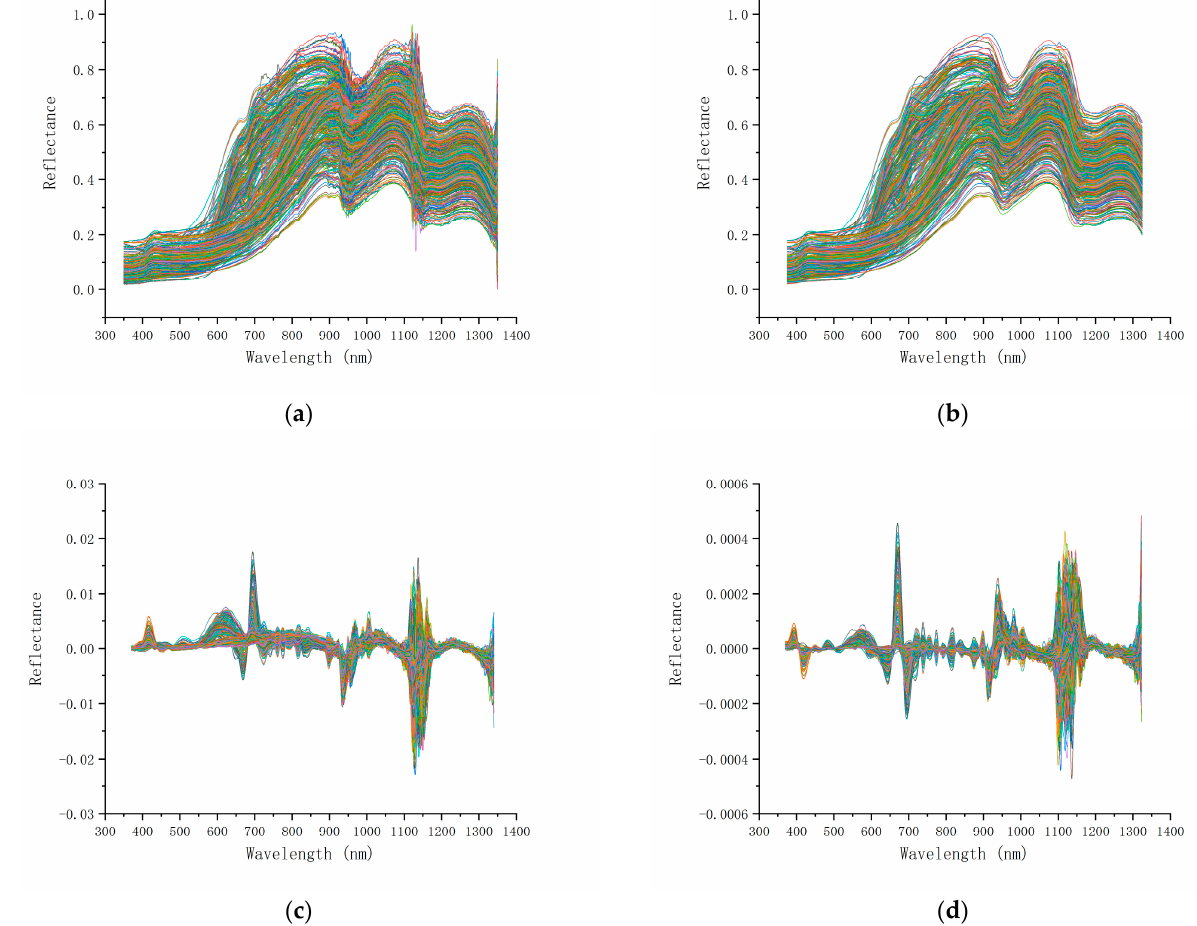
Figure 6. Spectral curves obtained using different preprocesses of derivation and SG smoothing: ( a ) original data; ( b ) frame size: 51, polynomial order: 3, differentiation order: 0; ( c ) frame size: 31, polynomial order: 4, differentiation order: 1; ( d ) frame size: 41, polynomial order: 2, differentiation order: 2.